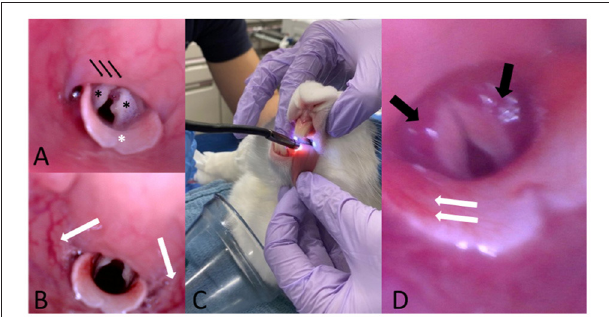
FIGURE 3 | (A) Representative pre-intubation image of normal endoscopic appearance of the laryngeal structures in one of the study animals. Note the two arytenoids (black asterisks), the epiglottis (white asterisk) and the soft palate (black arrows). (B) Representative post-intubation endoscopic image showing hyperemia of the pharyngeal walls. (C) Representative picture showing the scope insertion into the oral cavity with the rabbit maintained in sternal recumbency. One assistant gently pulls the tongue to facilitate the passage of the scope and head and neck are maintained extended. (D) Representative post-intubation endoscopic image showing bilateral hyperemia of the arytenoids (black arrows) and hyperemia of the epiglottis (white arrows).